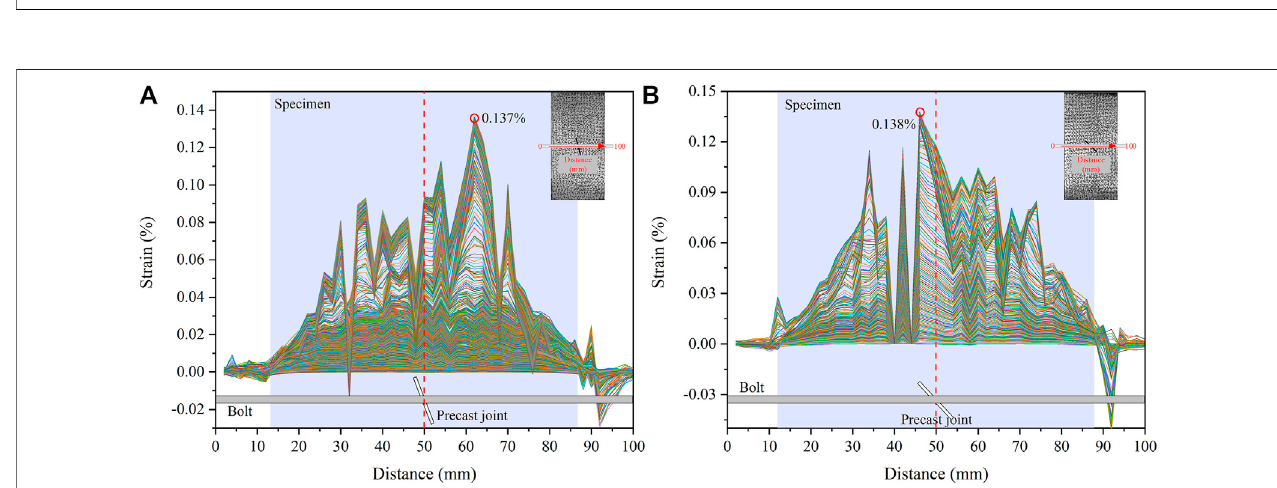
FIGURE 8 | Bolt strain of bolted jointed specimen under uniaxial compression: 75 ° (A) and 45 ° (B) bolted-joint specimen.